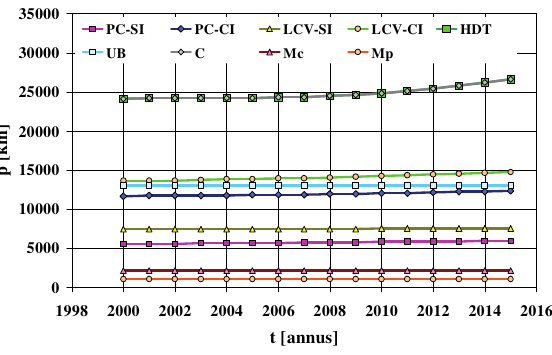
Fig. 2. Annual mileage of vehicles per cumulated category